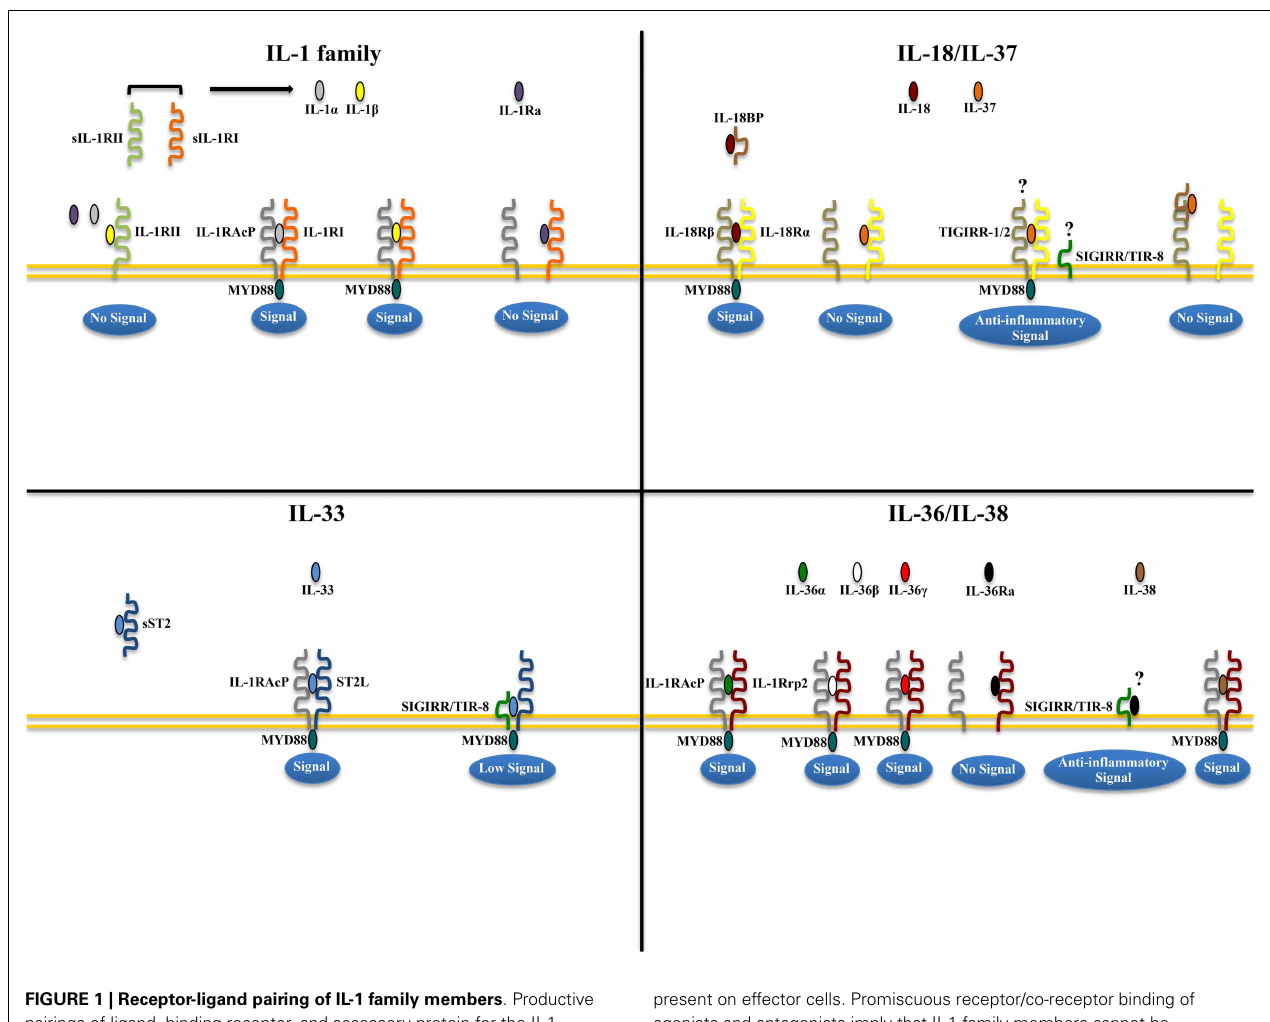
FIGURE 1 | Receptor-ligand pairing of IL-1 family members . Productive pairings of ligand, binding receptor, and accessory protein for the IL-1 (upper left), IL-18/IL-37 (upper right), IL-33 (lower left), and IL-36/IL-38 (lower right) systems.The overall bioactivity of IL-1 family agonists is dependent on the prevalent isoform and receptor binding domain/accessory protein